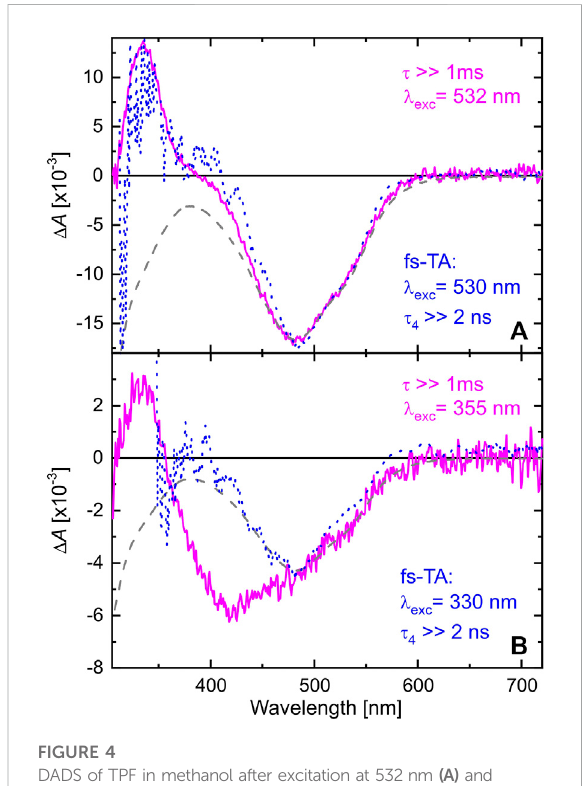
FIGURE 4 DADS of TPF in methanol after excitation at 532 nm (A) and 355 nm (B) .ThemagentaDADSresultfromaglobalmonoexponential fi ttothedataona1 mstimewindow.Thebluedashedcurvesarethe DADS corresponding to τ 4 of the fs-ns TA experiments (blue curves in Figures 3B,D) scaled to match the negative contribution at around 500 nm. The inverted absorption spectrum of the initial sample also scaled to the negative contribution at around 500 nm is given by a gray-dashed line for